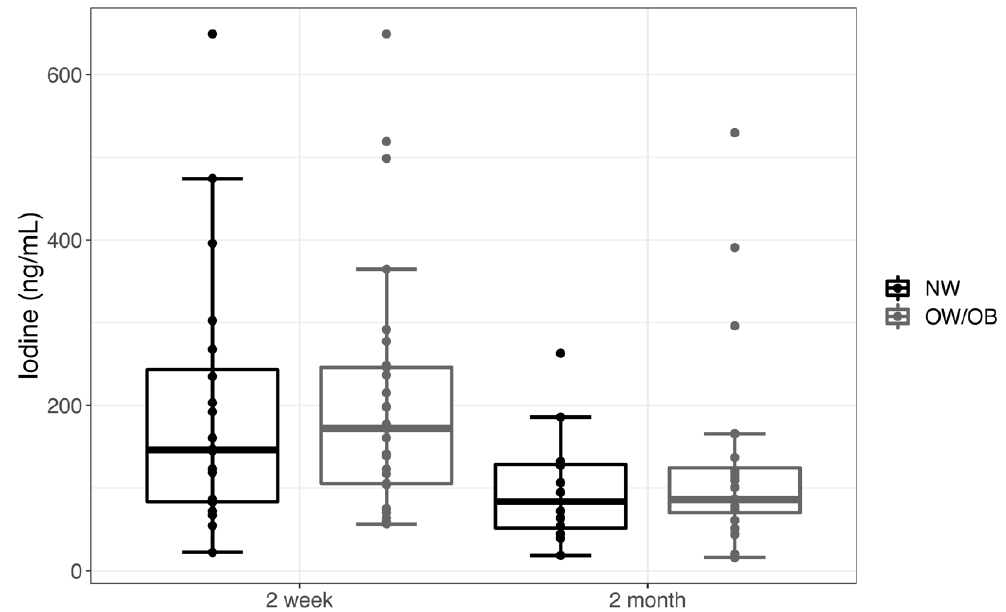
Figure 1. Breast milk iodine concentration (based on the maternal pre-pregnancy weight status for normal weight (NW) compared to overweight and obese (OW / OB) mothers) in transitional milk at 2 weeks (NW n = 20, OW / OB n = 29) and mature milk at 2 months (NW n = 12, OW / OB n = 20). Data are represented as a box plot, with the box showing median (IQR) and the whiskers equal to the farthest observation less than 1.5 times IQR from the box edge.